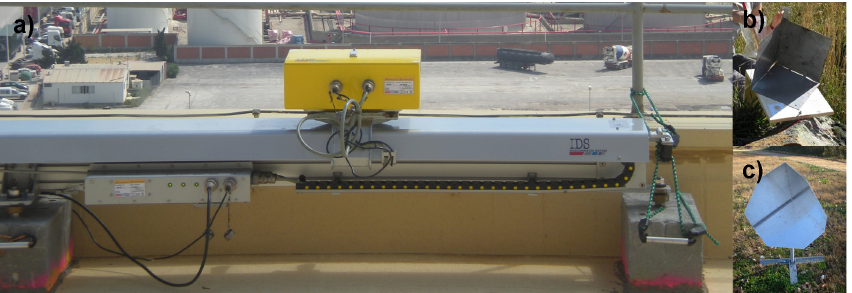
Fig. 4. (a) Picture of the GB-SAR system used in this work. The synthetic aperture is obtained through the movement of the radar sensor (yellow box) along the rail. (b) “First-generation CRs”. (c) “ New-generation